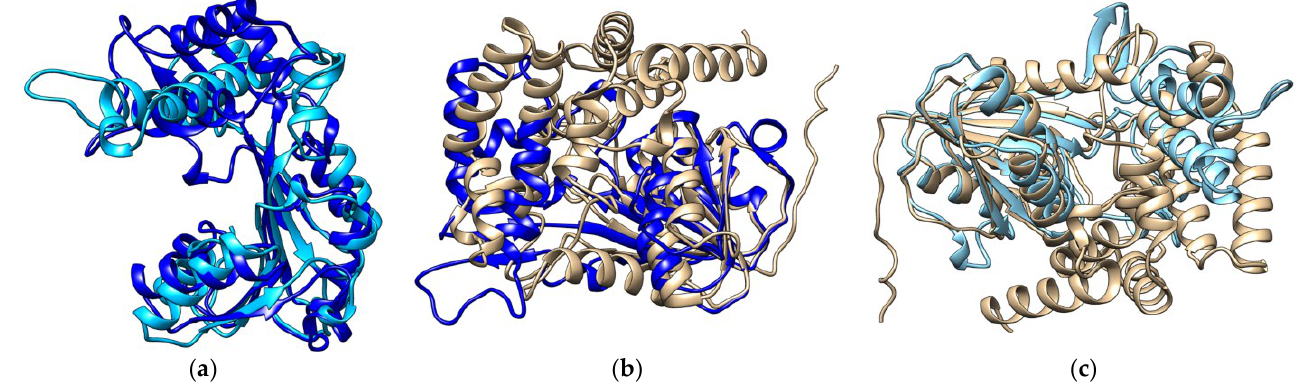
Figure 3. Structural comparison of the models by superimposition . ( a ) Superimposed image of protein XP (Light blue) on protein XM (dark blue). ( b ) Superimposed image of proteins ERG6 (YELLOW) and XM (DARK BLUE). ( c ) Superimposed image of proteins ERG6 (Yellow) and protein XP (light blue).